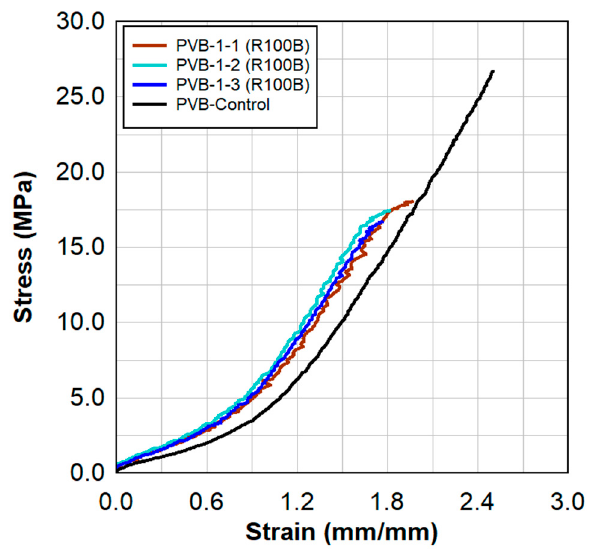
Figure 6. Static tensile test results for the PVB − 1 specimens and a comparison to the virgin PVB material.